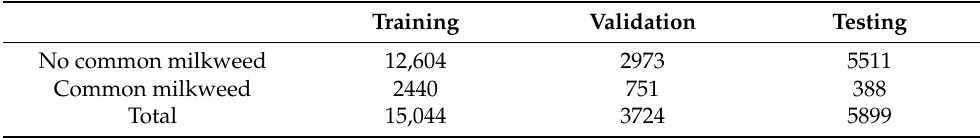
Table 2. Number of points in the training, validation, and testing sets.